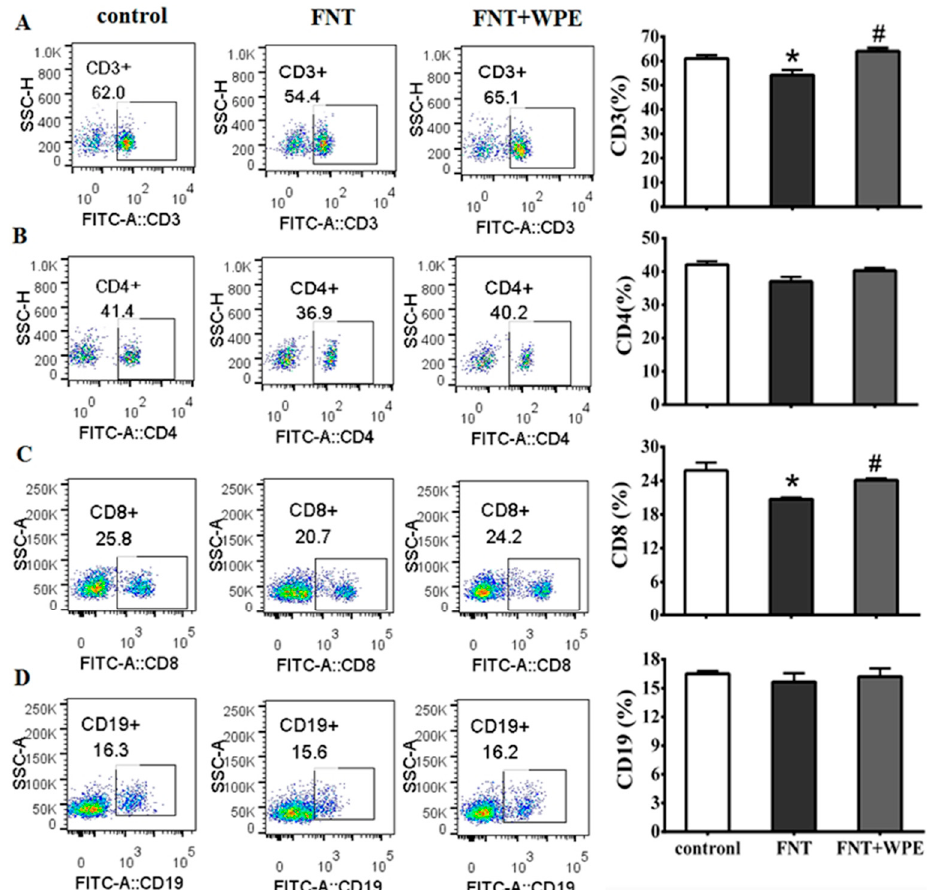
Figure 3. Percentages of various lymphocyte cell types as determined using flow cytometric analysis. ( A ) Cluster of differentiation (CD)3 + T-cells, ( B ) CD4 + T-cells, ( C ) CD8 + T-cells and ( D ) CD19 + B-cells in cells exposed to medium only (control), FNT or WPE together with FNT. Results shown are means ± SD of three separate experiments. * p < 0.05 vs. untreated control; # p < 0.05 vs. FNT treatment. (SSC: side scatter. FITC: fluorescein isothiocyanate.)